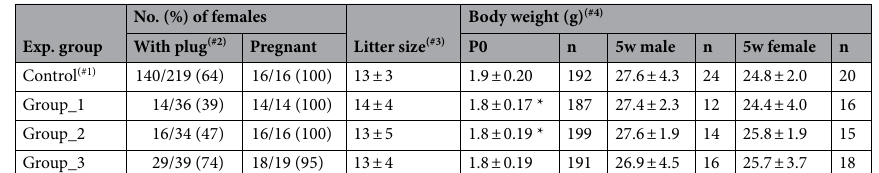
Table 2. Effects of LHRHa on copulation, and fetal and postnatal development. (#1) As a control, the data for calculating the frequency of copulation (data of “with plug”) in Fig. 2 were collected from the proestrus and estrus female mice using vaginal cytology and that in Fig. 3 were collected from LHRHa non-treated plug-positive female mice. (#2) Plug were checked one day after pairing with VAS male or WT mice. (#3) n: All pregnant females in each experimental group. (#4) n: All viable offspring in each experimental group. Fisher’s exact probability test with Bonferroni correction was performed to calculate the probability of “with plug” and “pregnant” mice. Kruskal–Wallis test with Bonferroni correction was performed for calculating the litter size and body weight of the offspring. *P < 0.001 vs. the corresponding value of the control.